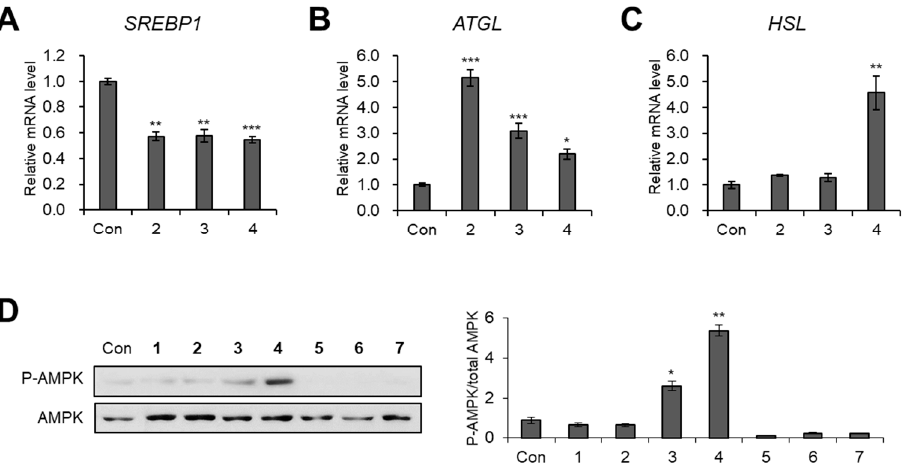
Figure 6. The inhibitory effects of compounds 1 – 7 on lipid metabolism. ( A – C ) The relative mRNA expression of SREBP1 ( A ), ATGL ( B ), and HSL ( C ) in 3T3-L1 adipocytes incubated with compounds 1 – 7 (20 µM) during adipogenesis. ( D ) Immunoblotting analysis of 3T3-L1 cells incubated with compounds 1 – 7 (20 µM) for 24 h. The data are presented as the mean ± SEM for n = 3 replicates. * p < 0.05, ** p < 0.01, and *** p < 0.001.